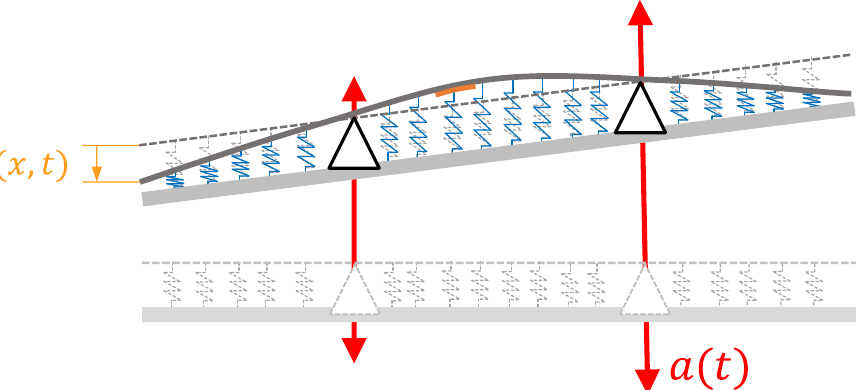
Figure 2. Vibrating slat. The inertia force causes an elastic deformation with respect to the rigid body motion.